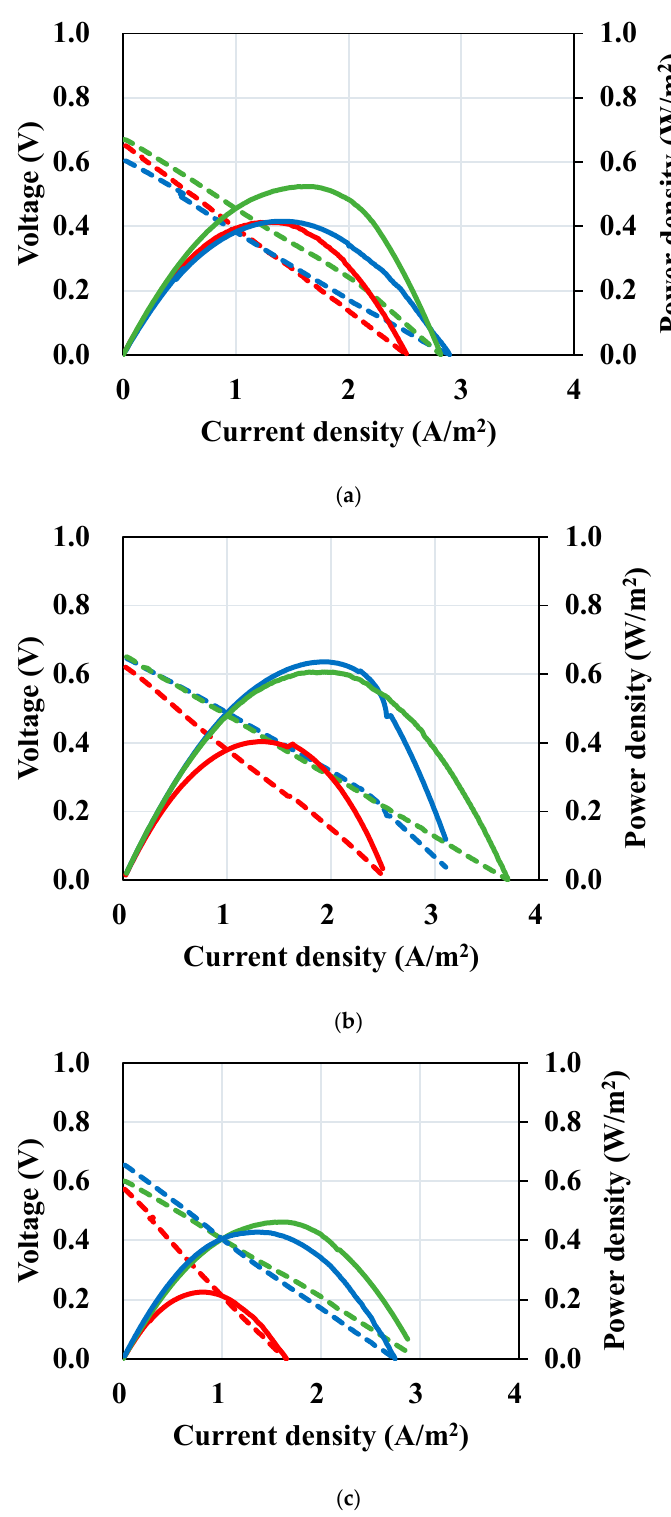
Figure 5. Polarization (dot line) and power curves (solid line) of S- (red), M- (blue), and L- (green) MFCs in a staked MFC system at phases I ( a ), II ( b ), and III ( c ).